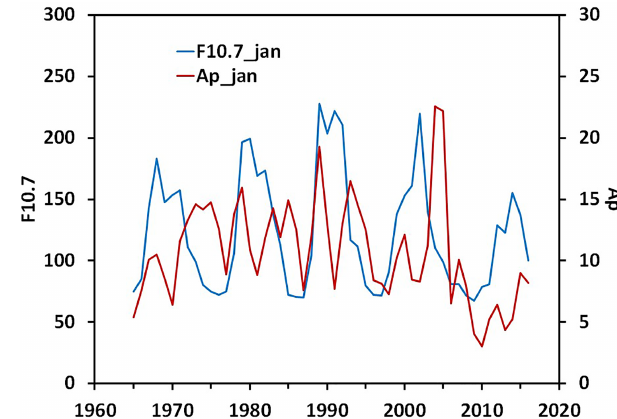
Figure 4. Monthly mean TOH in geomagnetic active years (Ap>8) and in geomagnetic quiet years (Ap ≤ 8). Vertical bars correspond to the standard deviations.